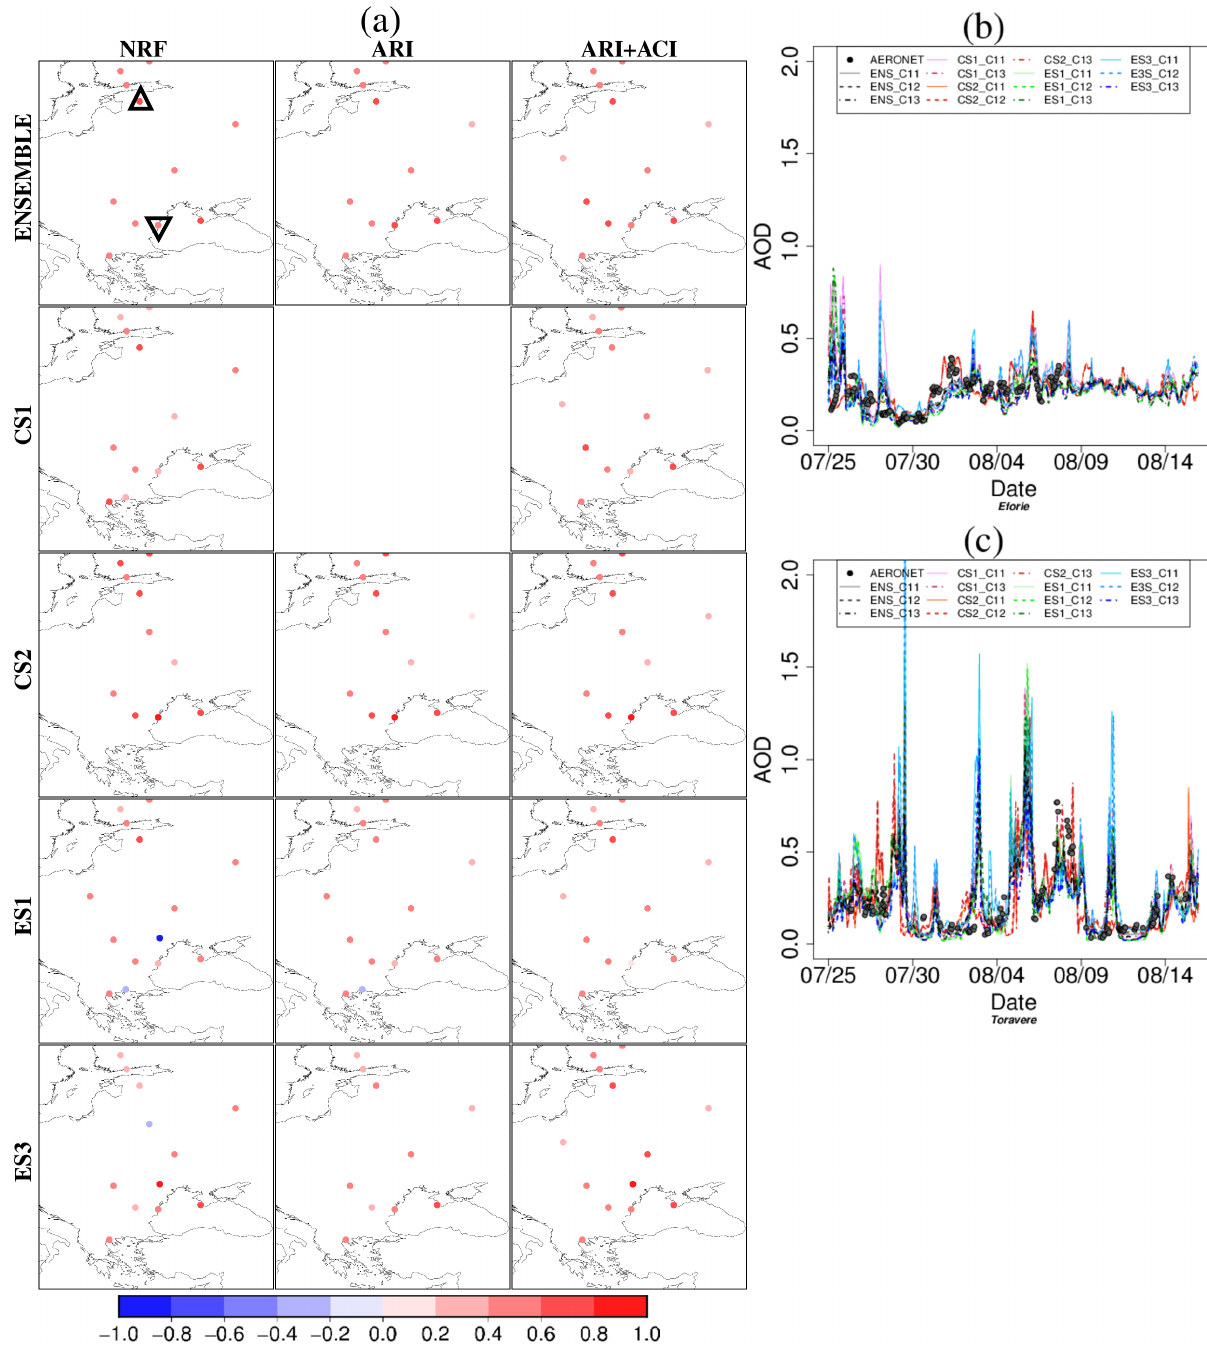
Figure 3. Model–AERONET comparison of AOD at 670nm for the Russian wildfires case: (a) temporal correlation values at each AERONET station, and (b) temporal series at the Eforie (located at triangle pointing upwards) and (c) Tõravere (located at triangle pointing downwards)